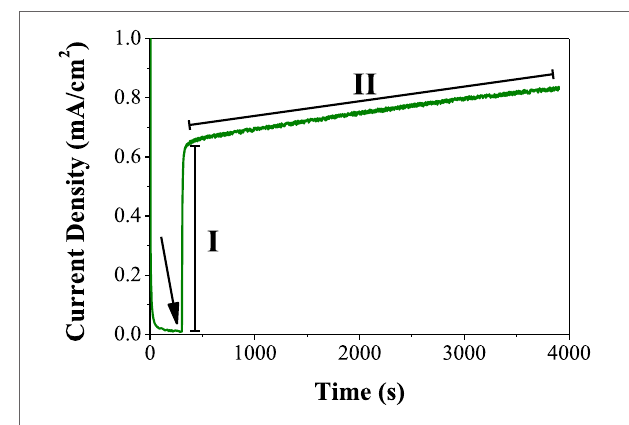
FigUre 8 | chronoamperometry at 0.6 V (vs. ag/agcl) of the caaO electrodes in 140 μ g FDh/ml–200 mM fructose . The arrow indicates the time point when the fructose was